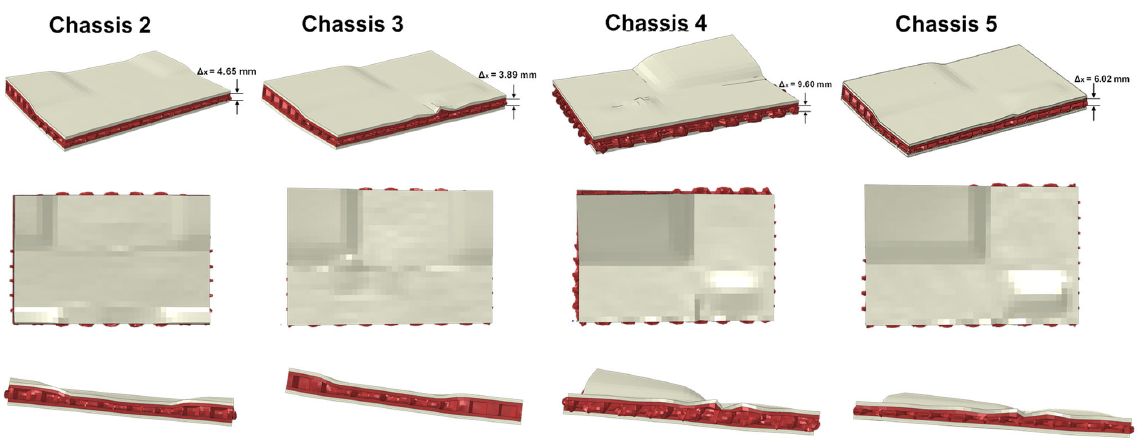
Figure 16. Shock absorbers’ deformed shape.